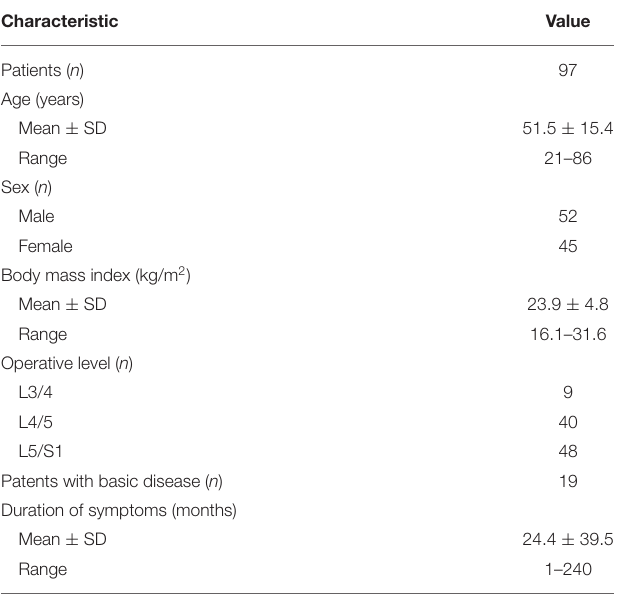
TABLE 1 | Demographic factors of patients included in this study.